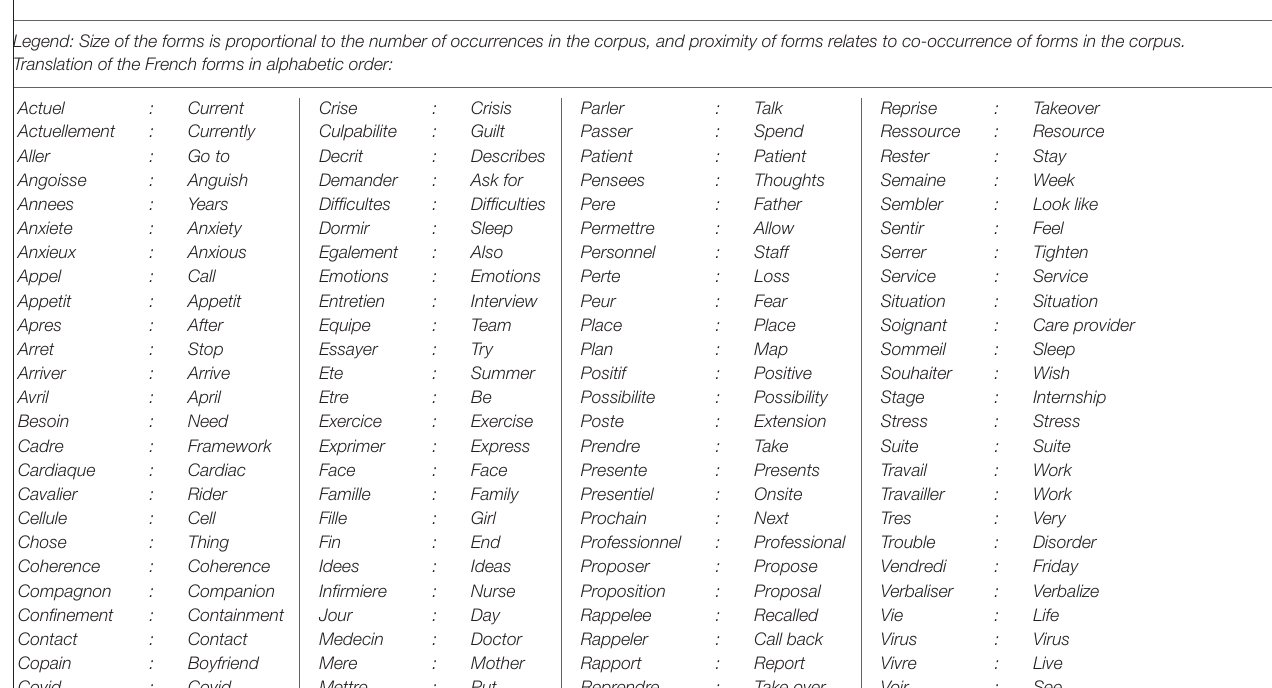
FIGURE 1 | Word cloud representing the relative importance and co-occurrence of the 100 main forms in the corpus.